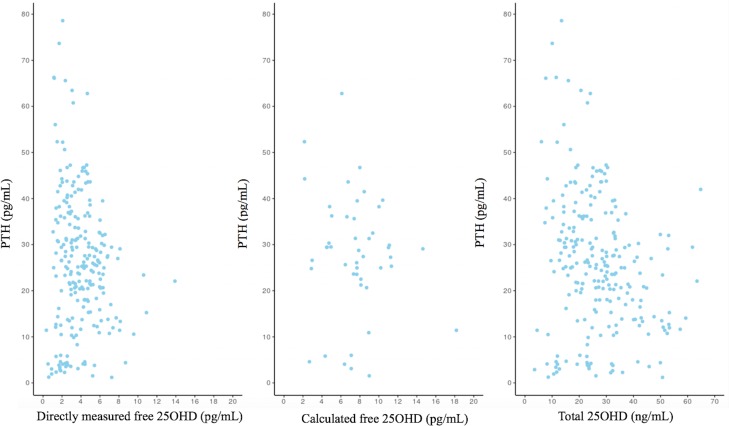
The correlation between the three different 25OHD values and PTH concentrations.